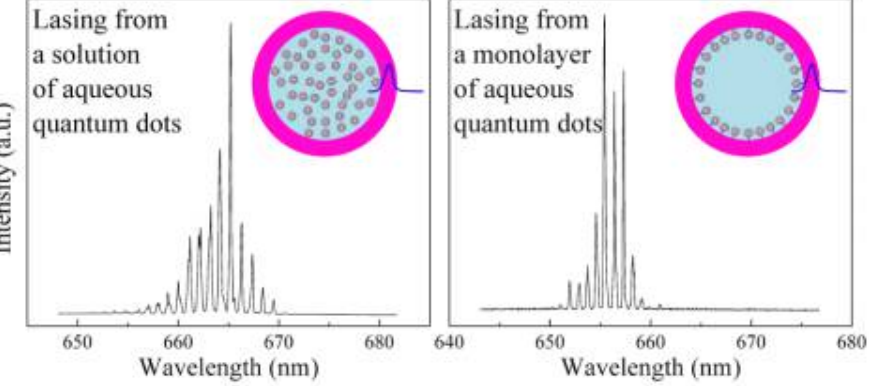
Figure 11. Spectrum of quantum-dot-filled fiber microcavity laser [29].